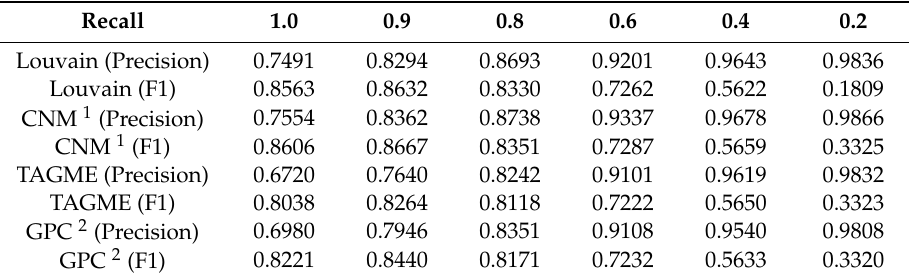
Table 1. Precision, recall and F1 score of Louvain and CNM methodology variants.